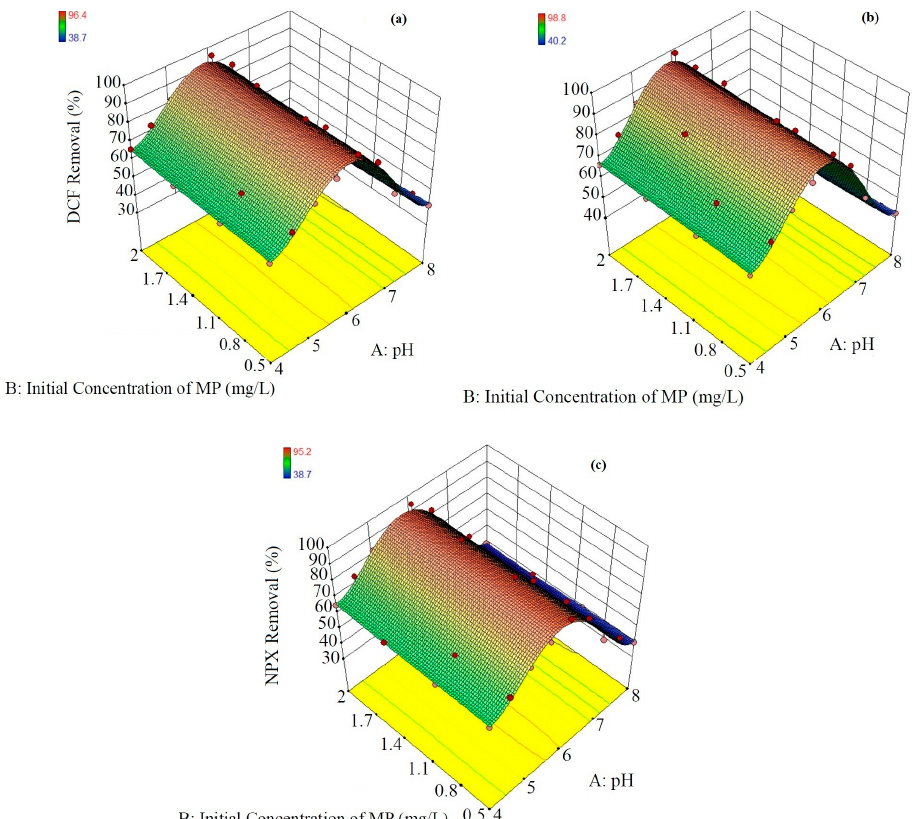
Figure 6. Removal efficiencies for diclofenac ( a ), ibuprofen ( b ), and naproxen ( c ).